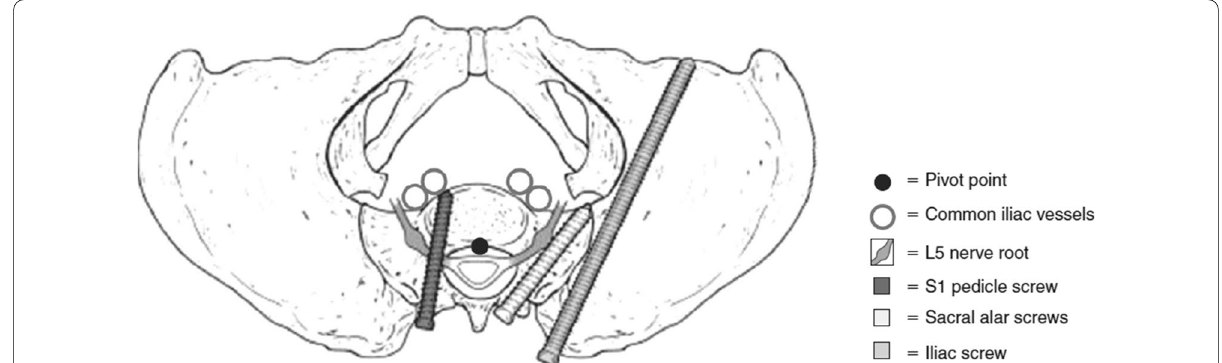
Fig. 2 Different options for sacropelvic fixation in relation to the pivot point and adjacent neurovascular structures